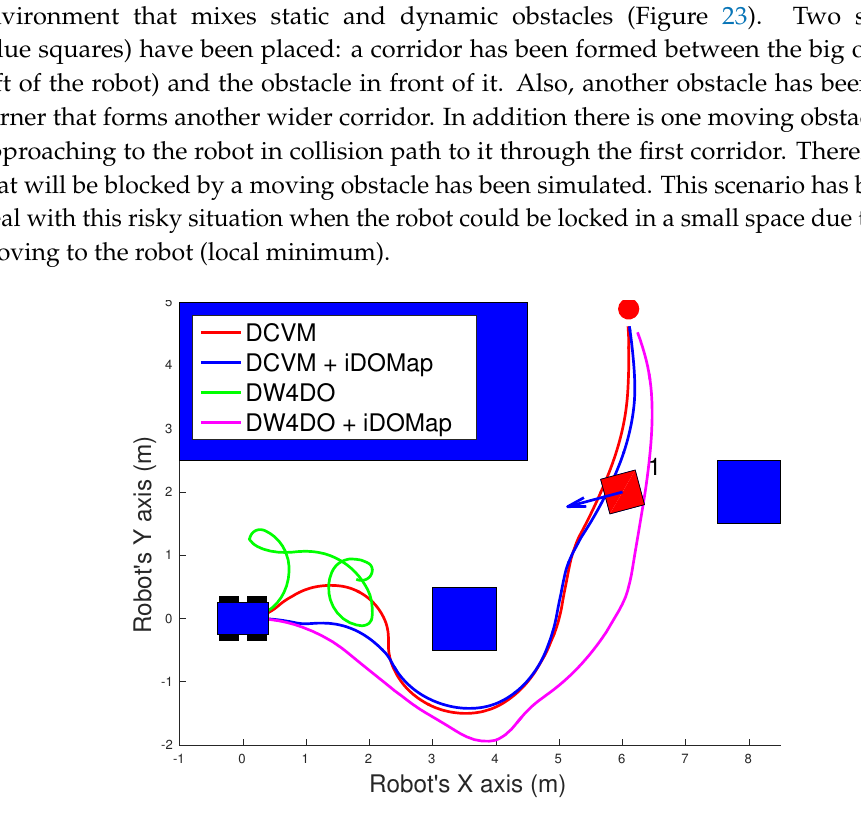
Figure 23. Scenario 2: Paths